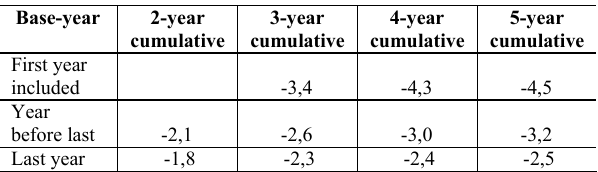
Table 3: Top decile of cumulative index-difference